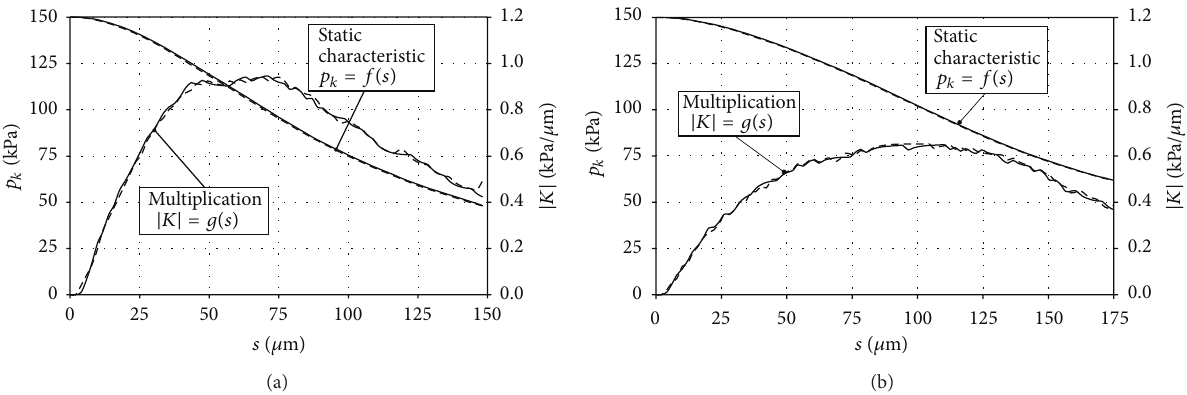
Figure 3: Examples of the experimentally obtained static characteristics and the multiplication graphs of air gauges.